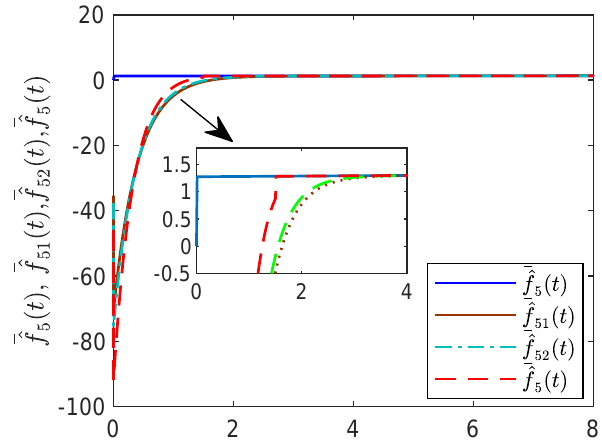
Figure 15. States ˆ¯ f (t), ˆ¯ f 51 (t), ˆ¯ f 52 (t), ˆ¯ f 5 (t) by the fixed-time reduced-order controller.